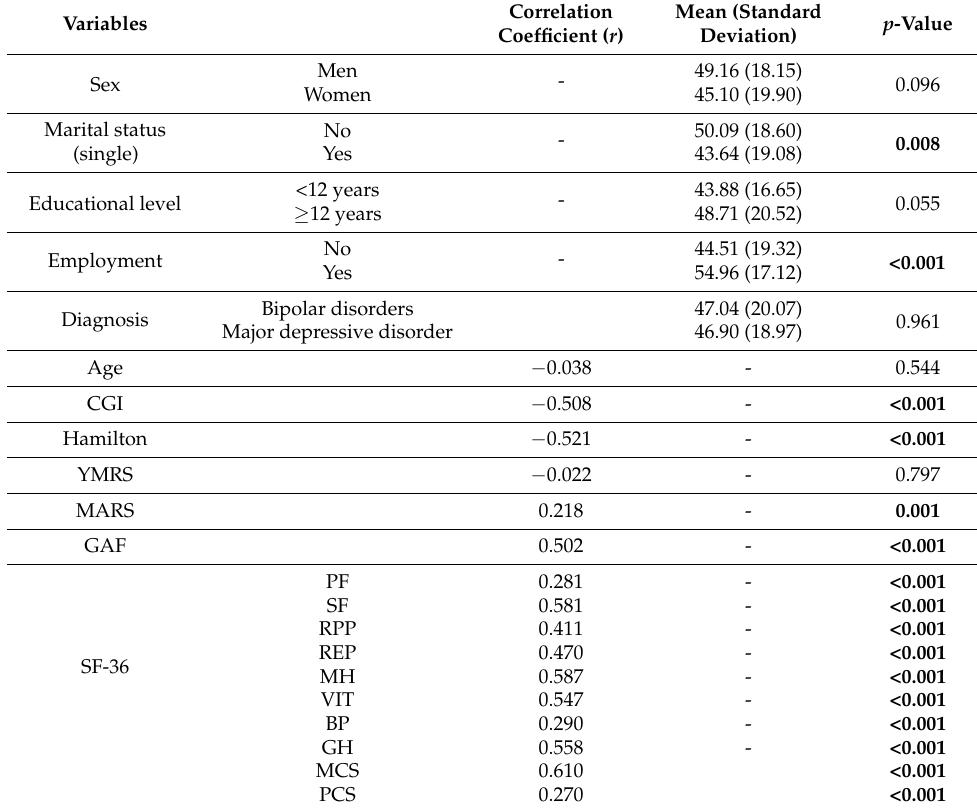
Table 3. External validity of the SQoL-18 ( n =